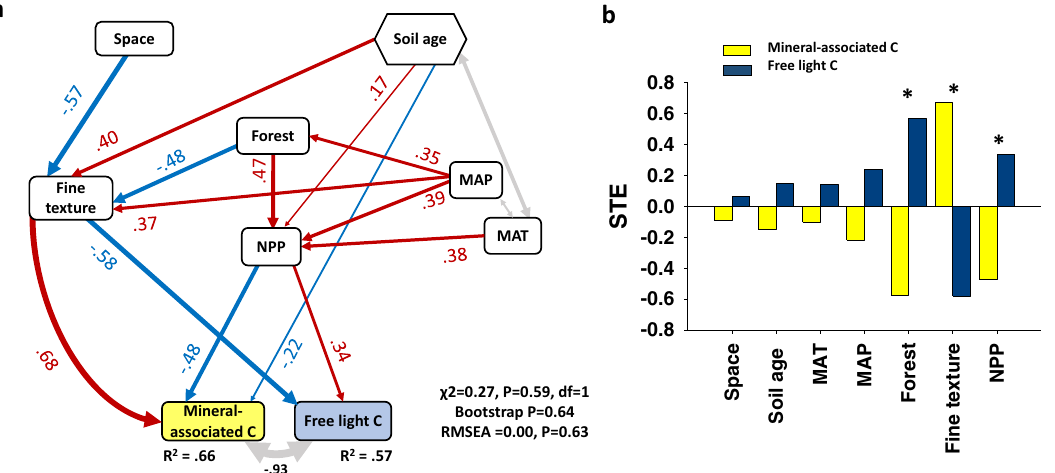
Fig. 3 Abiotic and biotic factors controlling the proportion of surface soil free light and mineral-associated carbon fractions across biomes. a includes a structural equation model (SEM) of signi fi cant relationships among variables ( p < 0.05) determining the proportion of carbon (C) fractions. Red and blue arrows represent positive and negative relationships, respectively, and their thicknesses the strength of the relationship. Numbers adjacent to arrows are standardized path coef fi cients, indicative of the sign and strength of the relationships among the variables. b shows the standardized total (direct + indirect) effects (STE) of abiotic and biotic predictors on the proportion of C fractions. MAT mean annual temperature, MAP mean annual precipitation, NPP (NDVI) plant productivity. Information on the direct effects for other SEM arrows can be found in Supplementary Table 2. * p < 0.05. Proportion of C fraction i (%) = C fraction i content × 100/sum of all C fraction contents. See text and Supplementary Data 1 for information on the